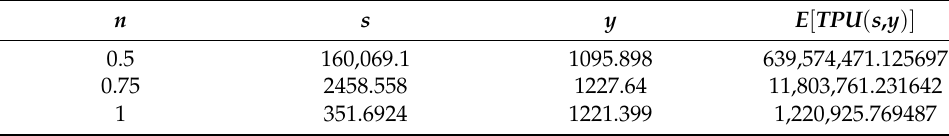
Table 1. Optimal solution for Example 1 for n = {0.5,0.75,1}.